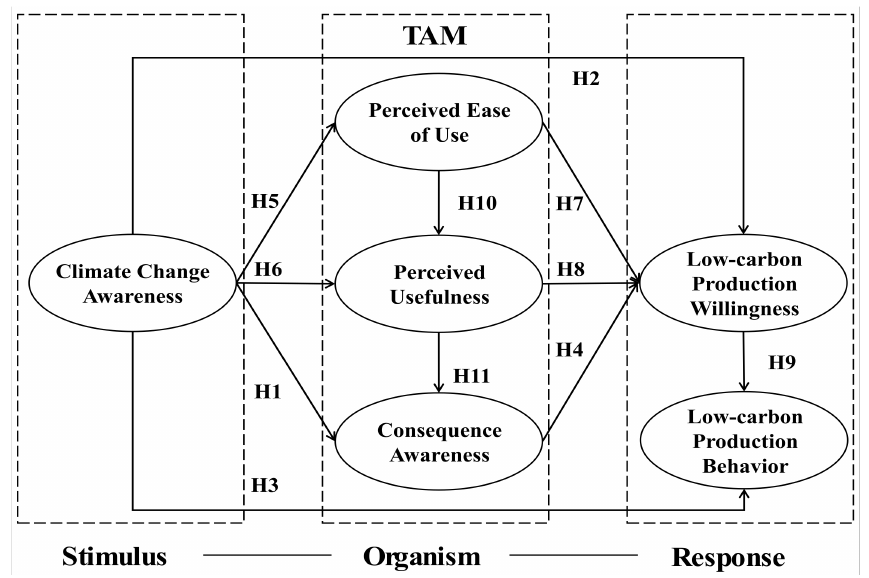
Figure 1. Theoretical model